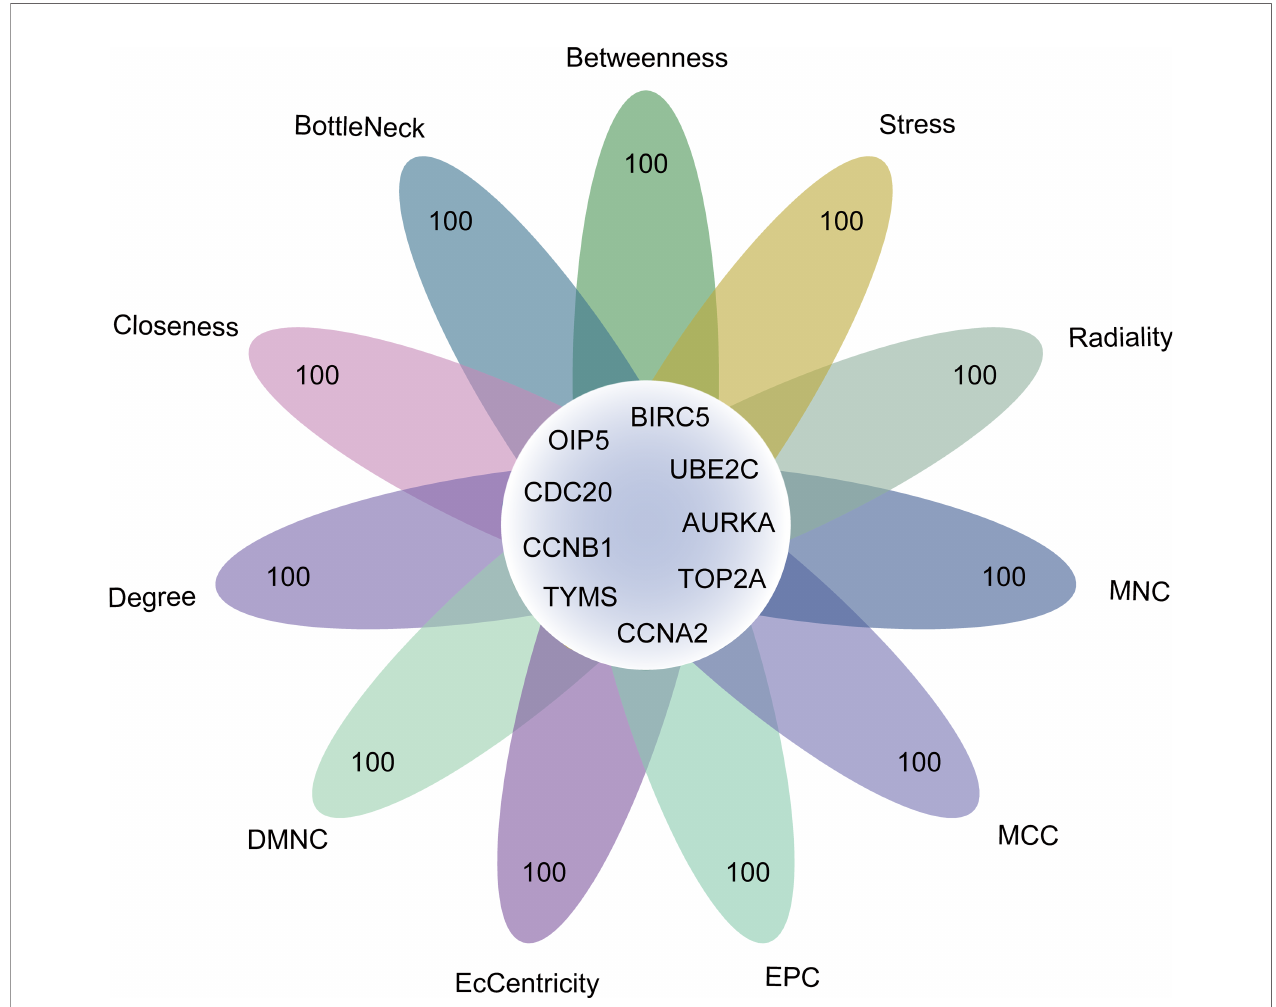
FIGURE 6 | The identi fi cation of 9 genes through intersecting genes from 11 ranking methods in the PPI network. Degree, node connect degree; DMNC, density of maximum neighborhood component; EPC, edge percolated component; MCC, maximal clique centrality; MNC, maximum neighborhood component; Closeness, node connect closeness; PPI, protein-protein